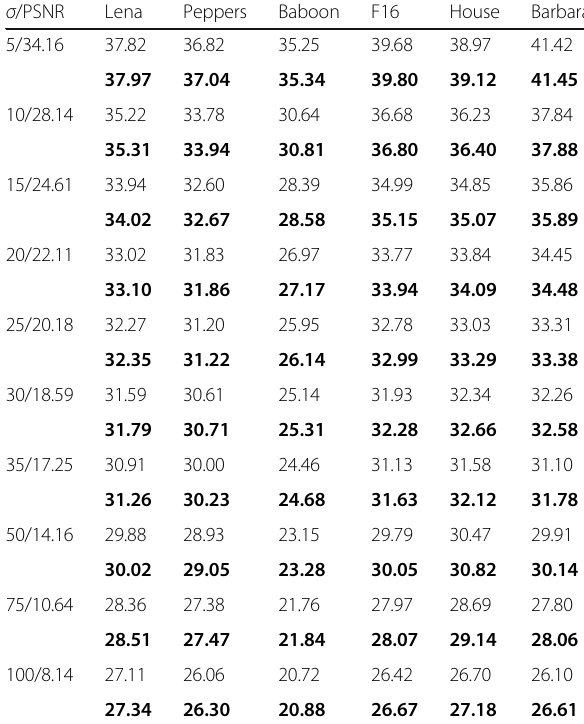
Table 4 Comparison of PSNR values obtained by BM3D and SA- BM1-3D on color images. In each cell, the upper number is for BM3D while the lower number is for SA-BM1-3D σ